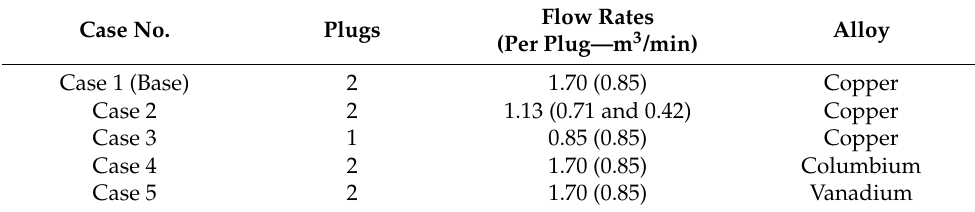
Table 3. Case Matrix.